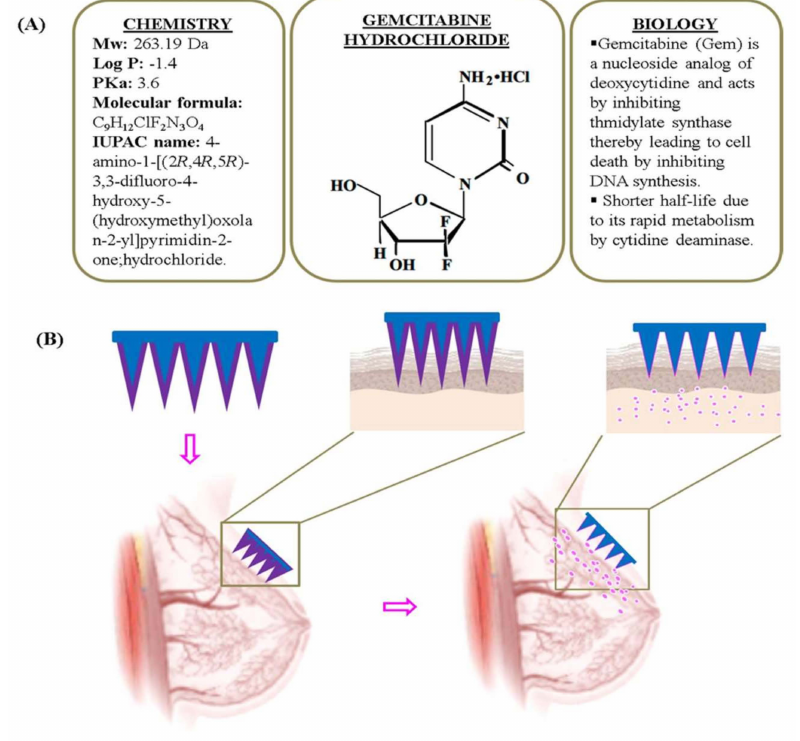
Figure 1. Gemcitabine (Gem) coated microneedles (MNs) ( A ) Gem hydrochloride chemical structure, chemistry and biology ( B ) Coat and poke strategy: insertion of Gem coated MNs and delivery of Gem into the layers of